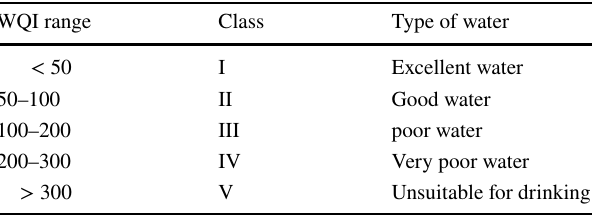
Table 3 Water quality classification based on WQI values (Sahu and Sikdar